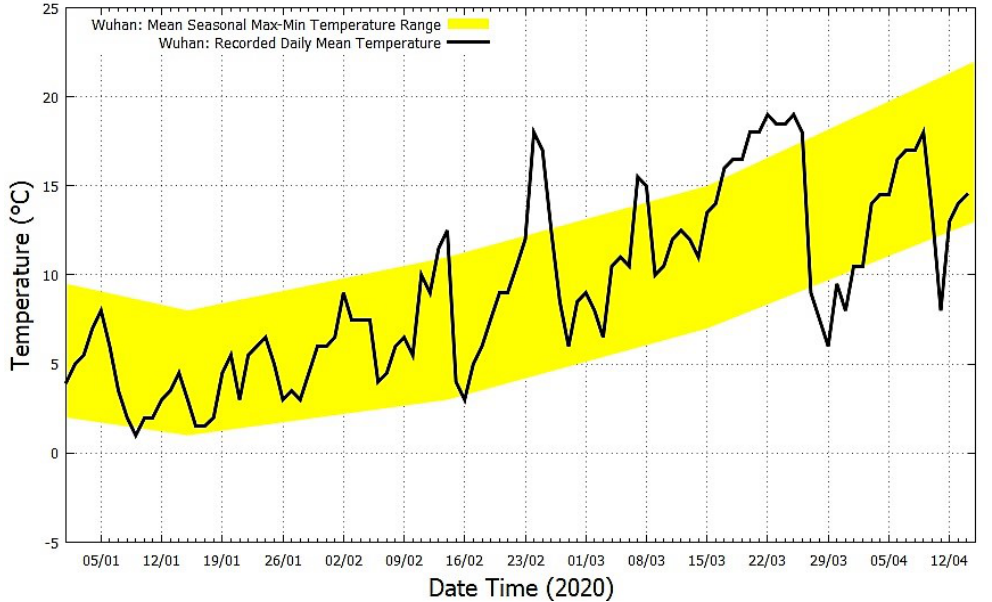
Figure 5. The daily mean temperature record of Wuhan (black) and its climatic temperature averages (yellow).